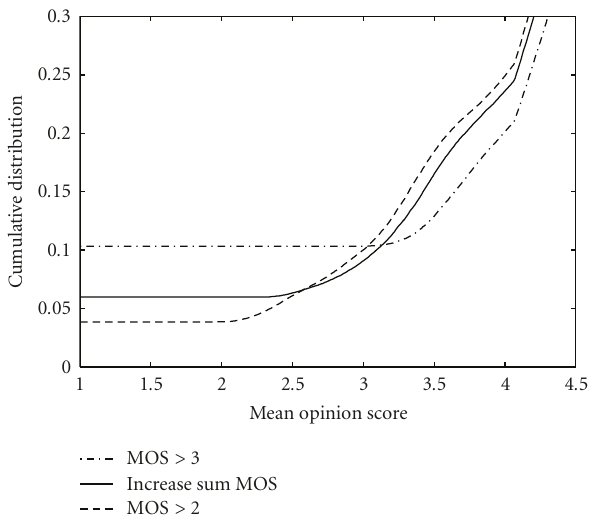
Figure 12: CDF of the perceived quality for ordinary and premium tra ffi